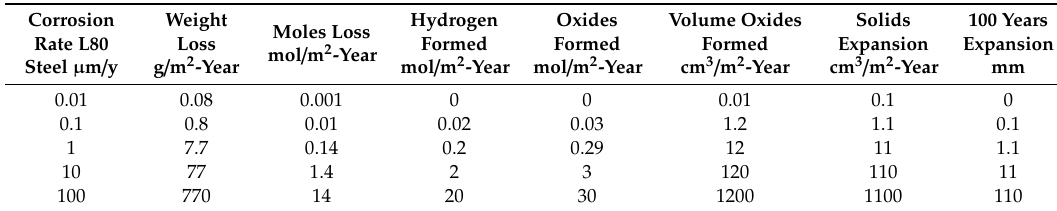
Table 3. E ff ect of corrosion rate of L80 steel on metal loss, hydrogen generation, oxide formation, and solids